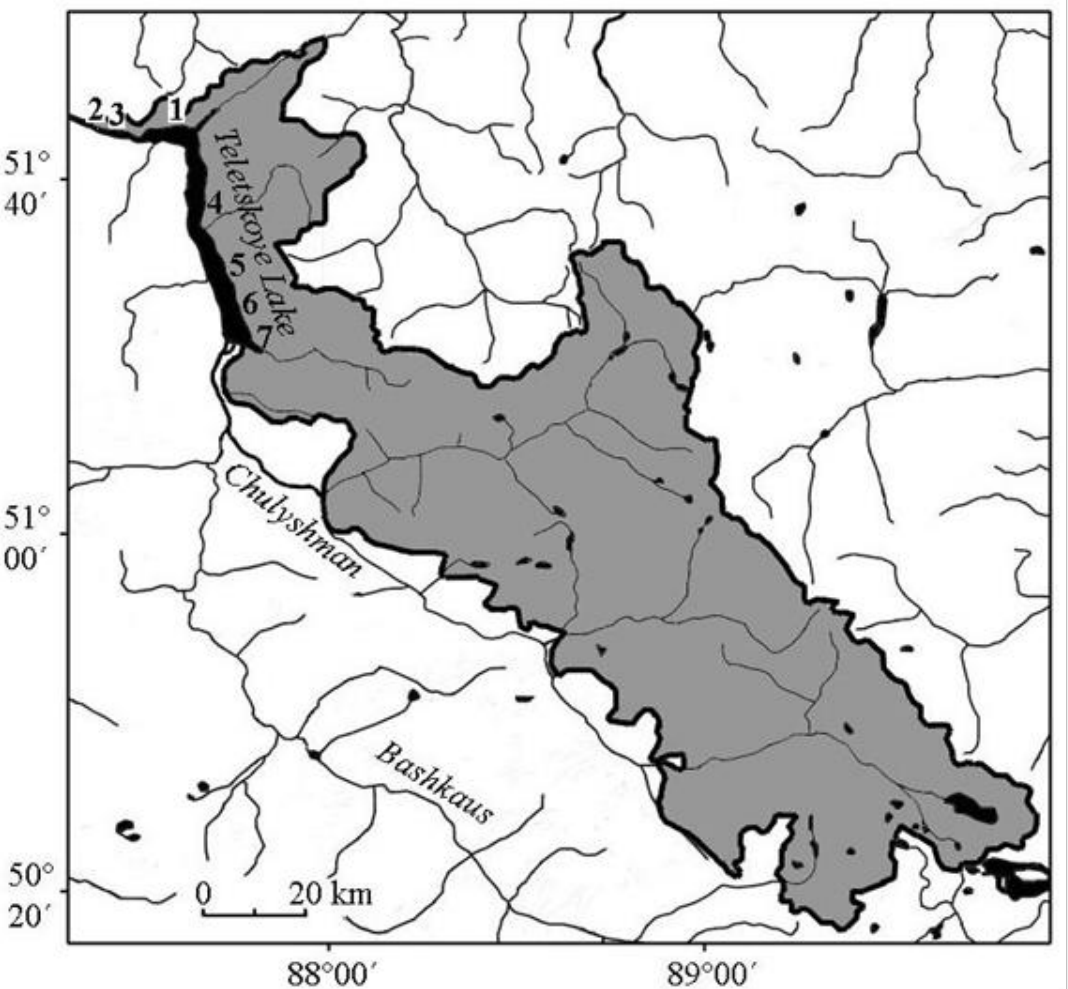
Fig. 2 Altaiskiy State Nature Biosphere Reserve: 1 – Yaylyu village; ranger stations: 2 – Karatash, 3 – Baygazan, 4 – Kokshi,